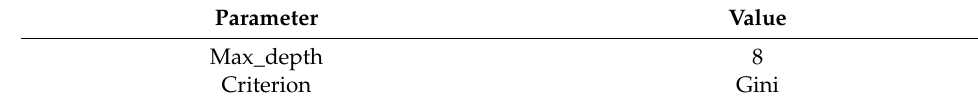
Table 6. Decision Tree Parameter.